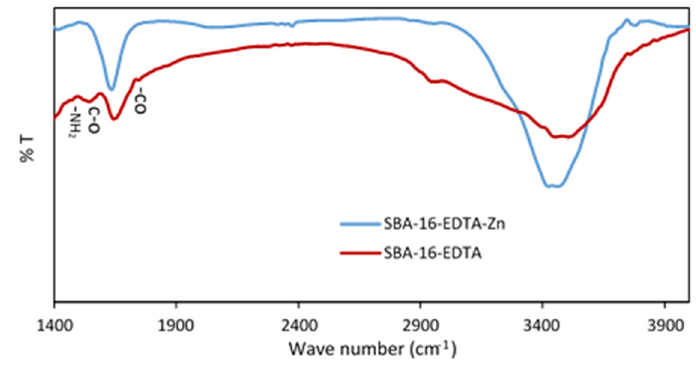
Figure 8. FTIR spectra for SBA ‒ 16 ‒ EDTA after zinc adsorption.